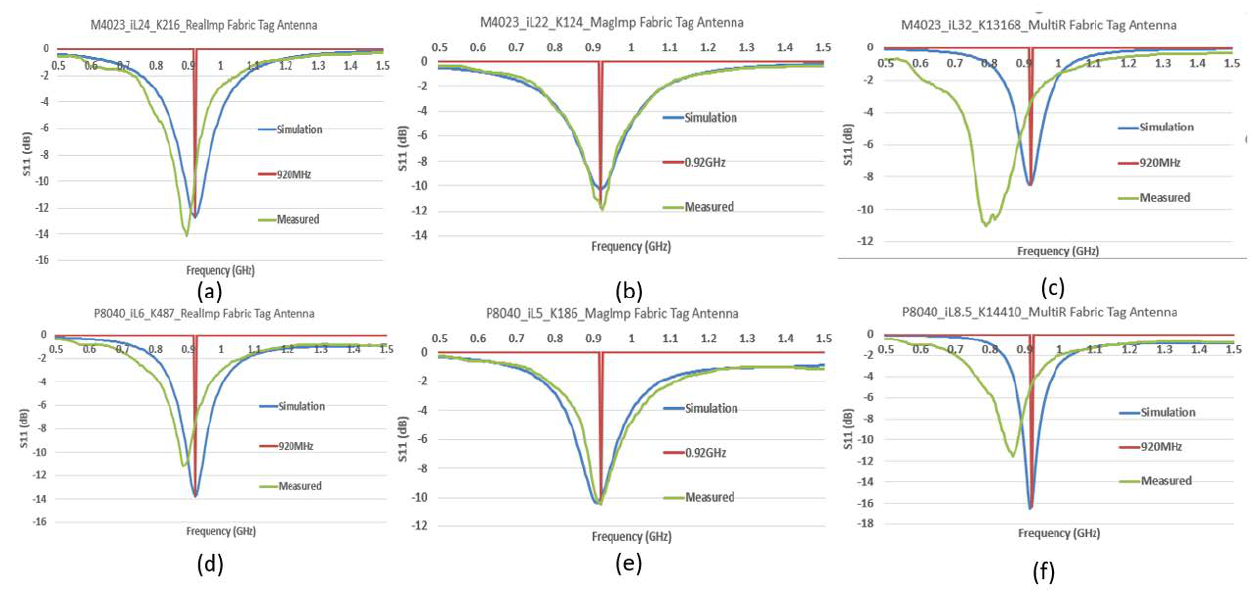
Figure 11. Comparison of simulated and measured reflection coefficients of M4023 and